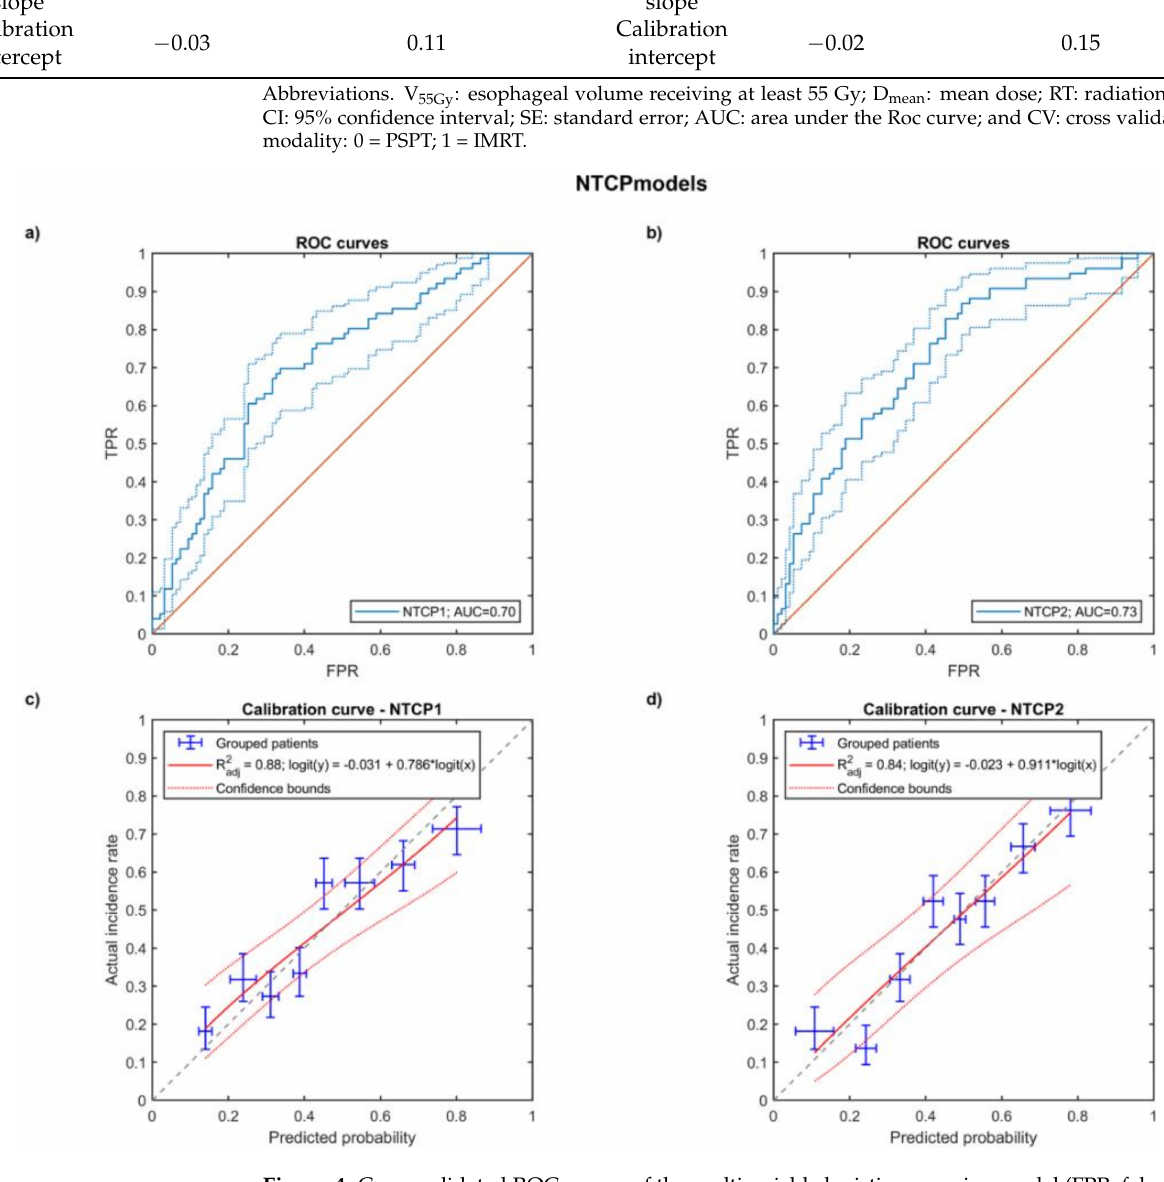
Figure 4. Cross-validated ROC curves of the multivariable logistic regression model (FPR: false positive rate, TPR: true positive rate) for NTCP 1 ( a ) and NTCP 2 ( b ); cross-validated calibration plot for NTCP 1 ( c ) and NTCP 2 ( d ), the error bars for the reported values represent the 68% confidence